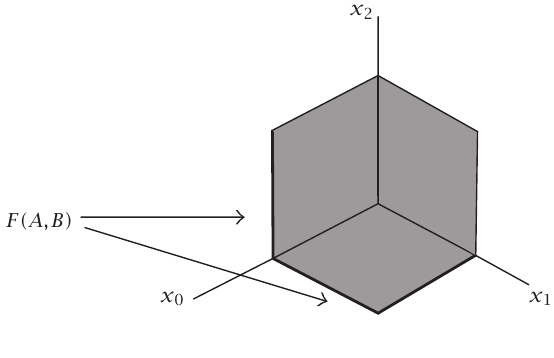
Figure 2.3 . A 1-face of ∆